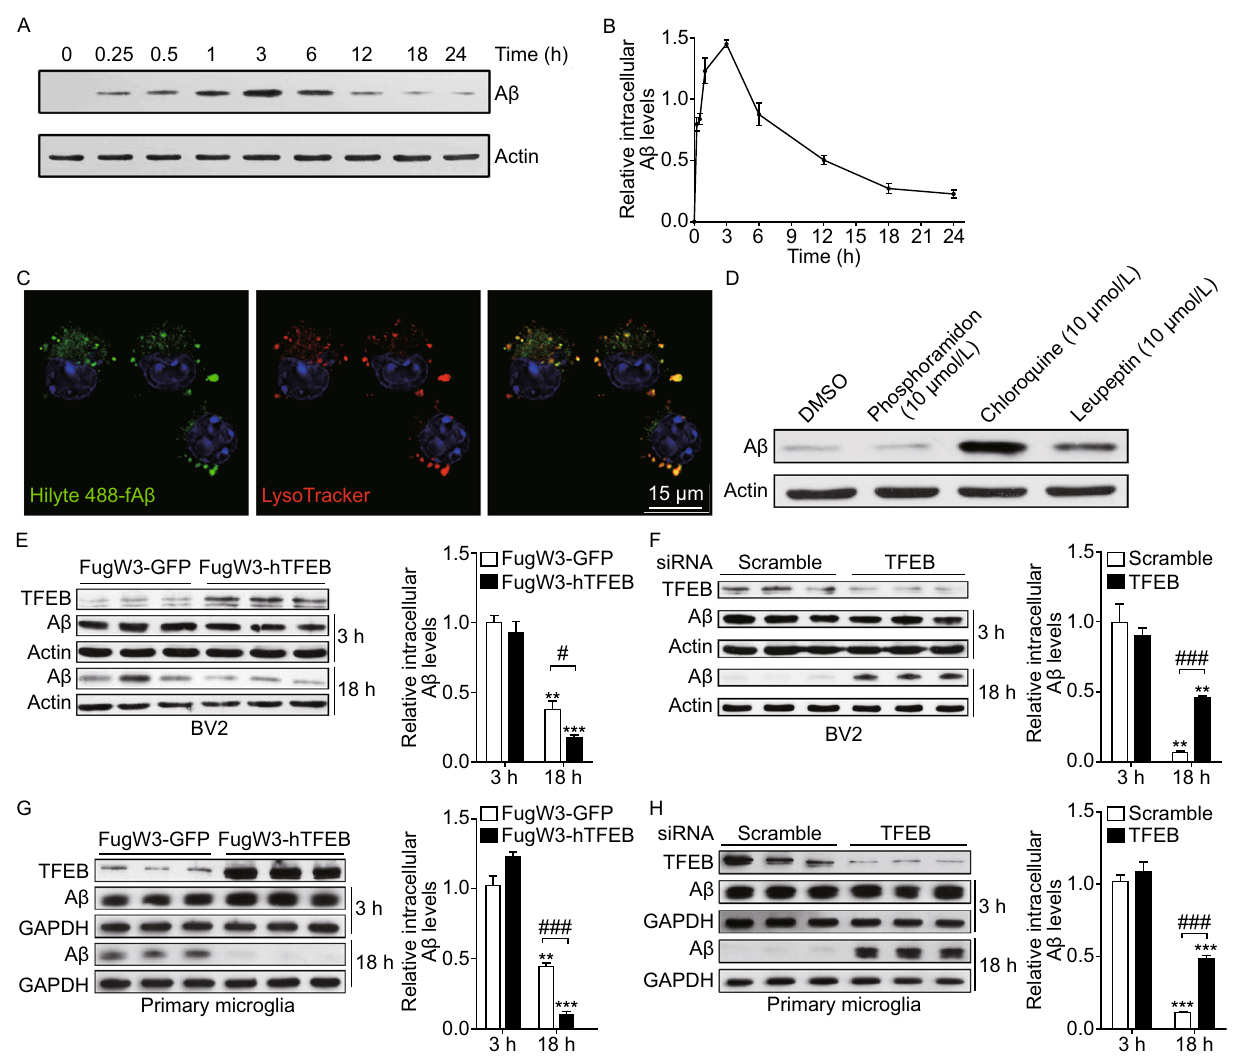
Figure 1. TFEB enhances microglial degradation of fi brillar A β in lysosomes. (A and B) Microglia internalize and ef fi ciently degrade fi brillarA β .BV2cellswereincubatedwithfA β (500nmol/L)at37°Candthecellswereharvestedandlysedatdifferenttimepoints, followed by detection of intracellular A β levels by Western blotting analysis (A). The band intensity was measured in three independent experiments indicating relative intracellular A β levels and the mean ± SEM are shown in (B). (C) Fibrillar A β is rapidly traf fi cked into lysosomes.ConfocalimagingofliveBV2cells30minafteradditionofHilyte488-labeledfA β (500nmol/L)showedlocalizationoffA β (Green) within lysosomesstainedwith LysoTracker(Red).Scale bar, 15 μ m.(D) InternalizedfA β isdegradedinlysosomes. Primary microgliafrom wild-type mice were pretreated with DMSO, Phosphoramidon (NEP inhibitor, 10 μ mol/L), Chloroquine or Leupeptin (Lysosome inhibitor, 10 μ mol/L) for 18 h. The cells were then incubated with fA β (500 nmol/L) in the presence of DMSO or inhibitors for an additional 18 h. The